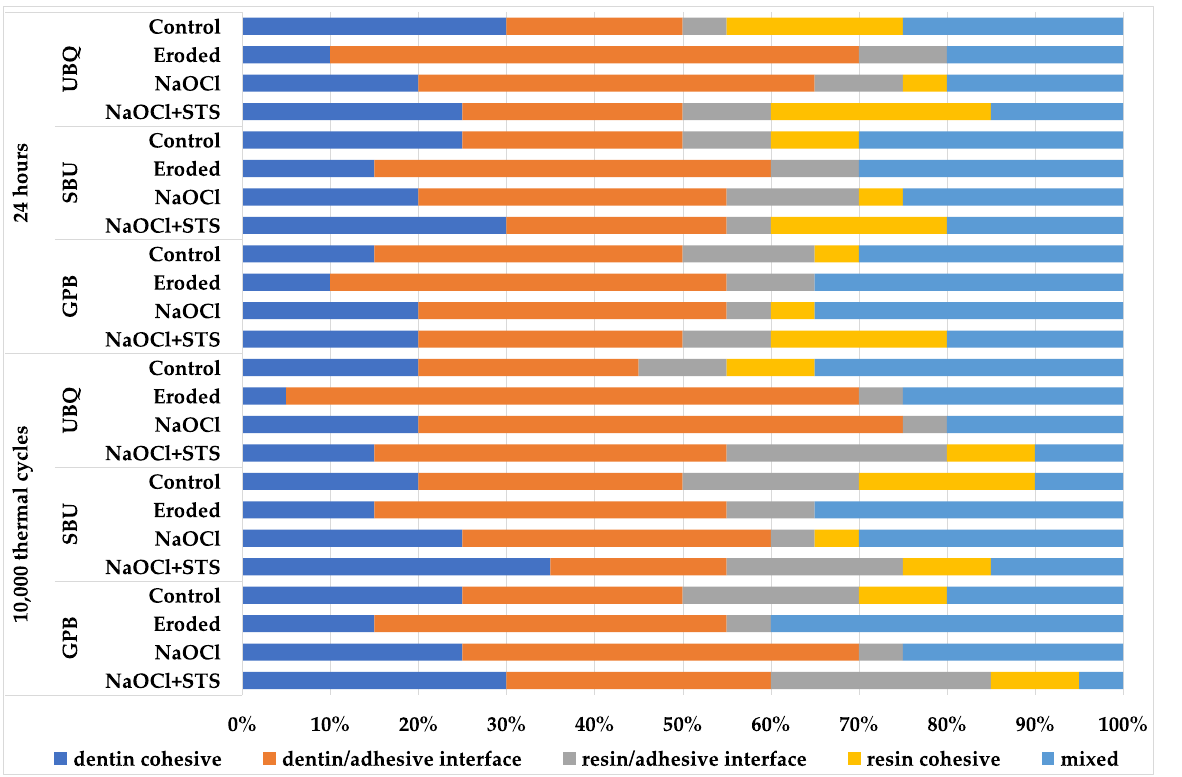
Figure 1. Distribution of failure modes in percentage.